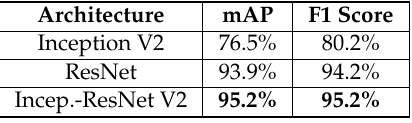
Table 4. Summary of detection performance metrics of Inception-ResNet V2, Inception V2 and ResNet101 neural network architectures. Bold data indicates the highest score obtained for each metric.